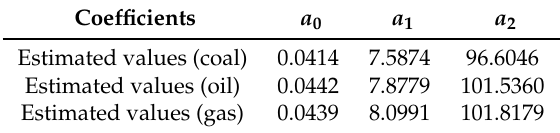
Table 2. Estimated coefficients of cubic cost function using the ABC